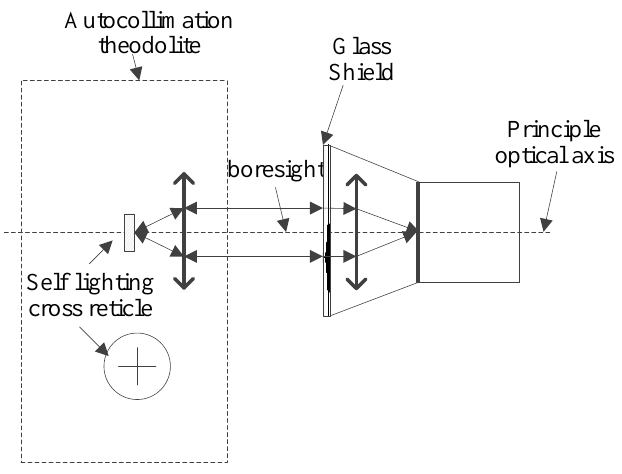
Figure 17. Principal point measurement